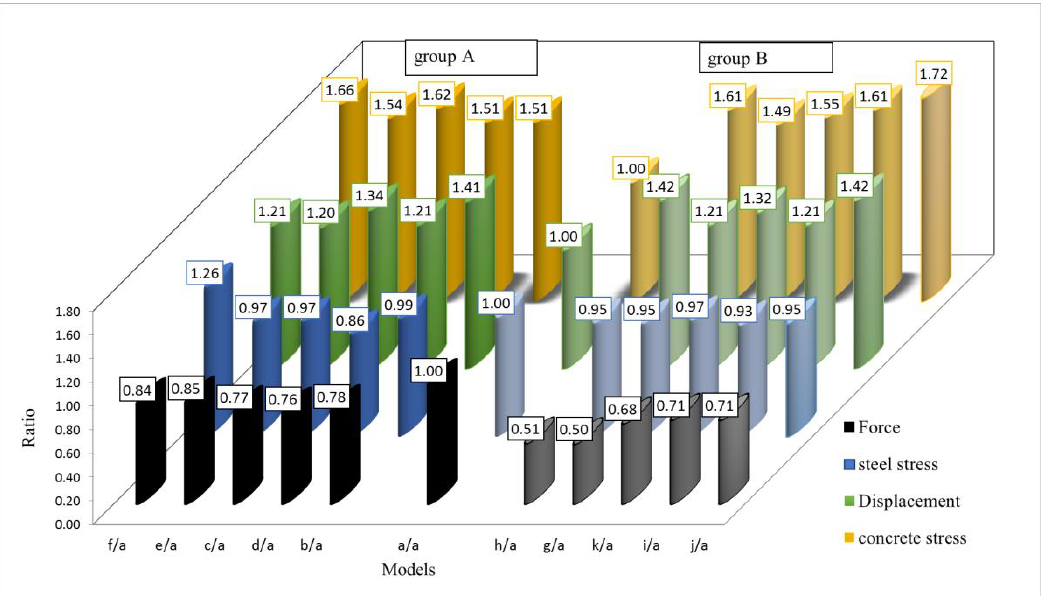
Figure 38. Fit toolbox results for the neural network result.